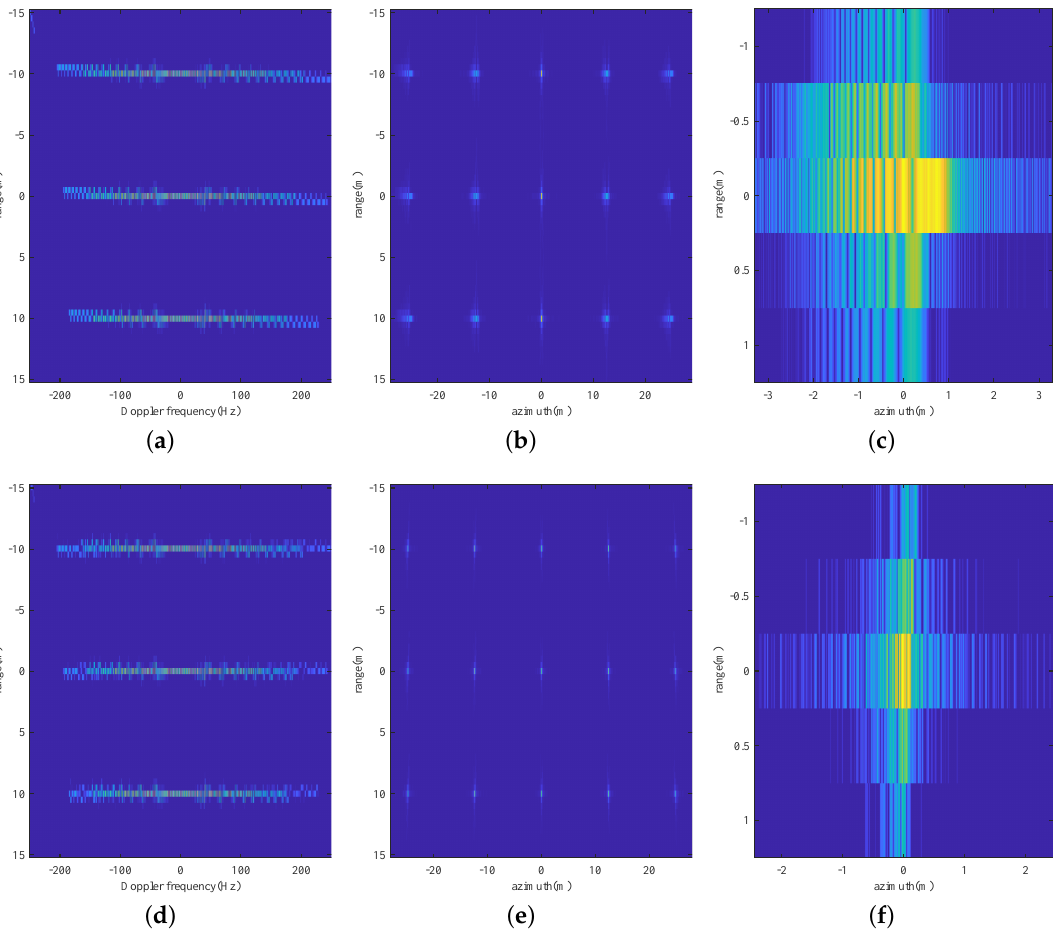
Figure 3. Point target verification of the imaging algorithm: ( a ) range profile without two-stage RCMC, ( b ) focused image without two-stage RCMC and ANCS, ( c ) intensity in dB of the scatterer in the left bottom corner without two-stage RCMC and ANCS, ( d ) range profile after two-stage RCMC, ( e ) focused image with two-stage RCMC and ANCS, ( f ) intensity in dB of the scatterer in the left bottom corner after two-stage RCMC and